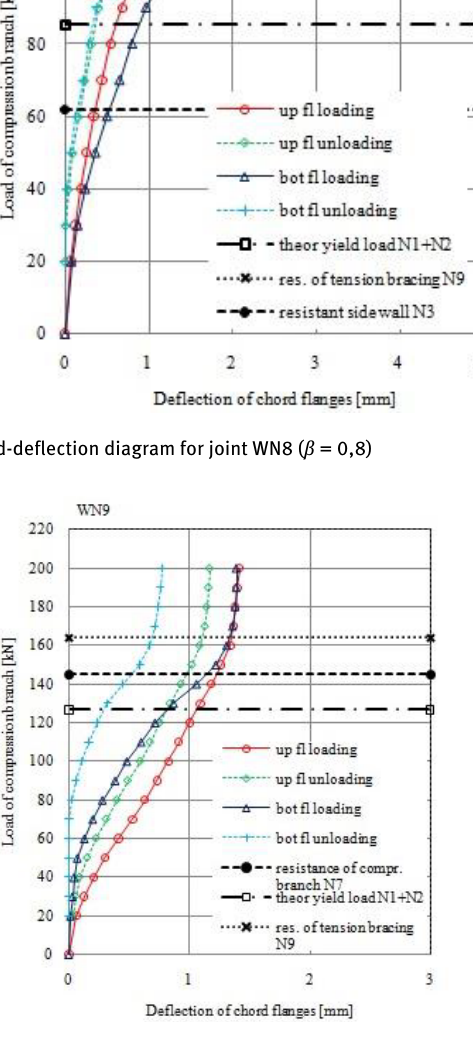
Figure 13: Load-deflection diagram for joint WN9 ( β =